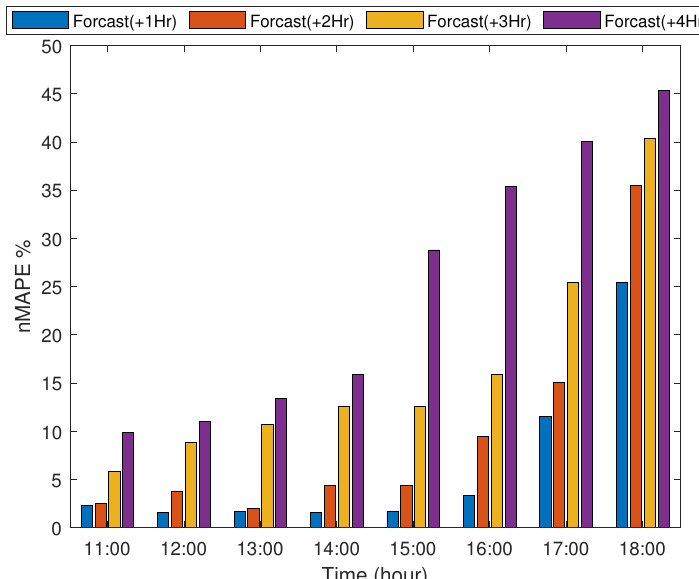
Figure 5. Hourly nMAPE forecast of +1, +2, +3, and +4 h.